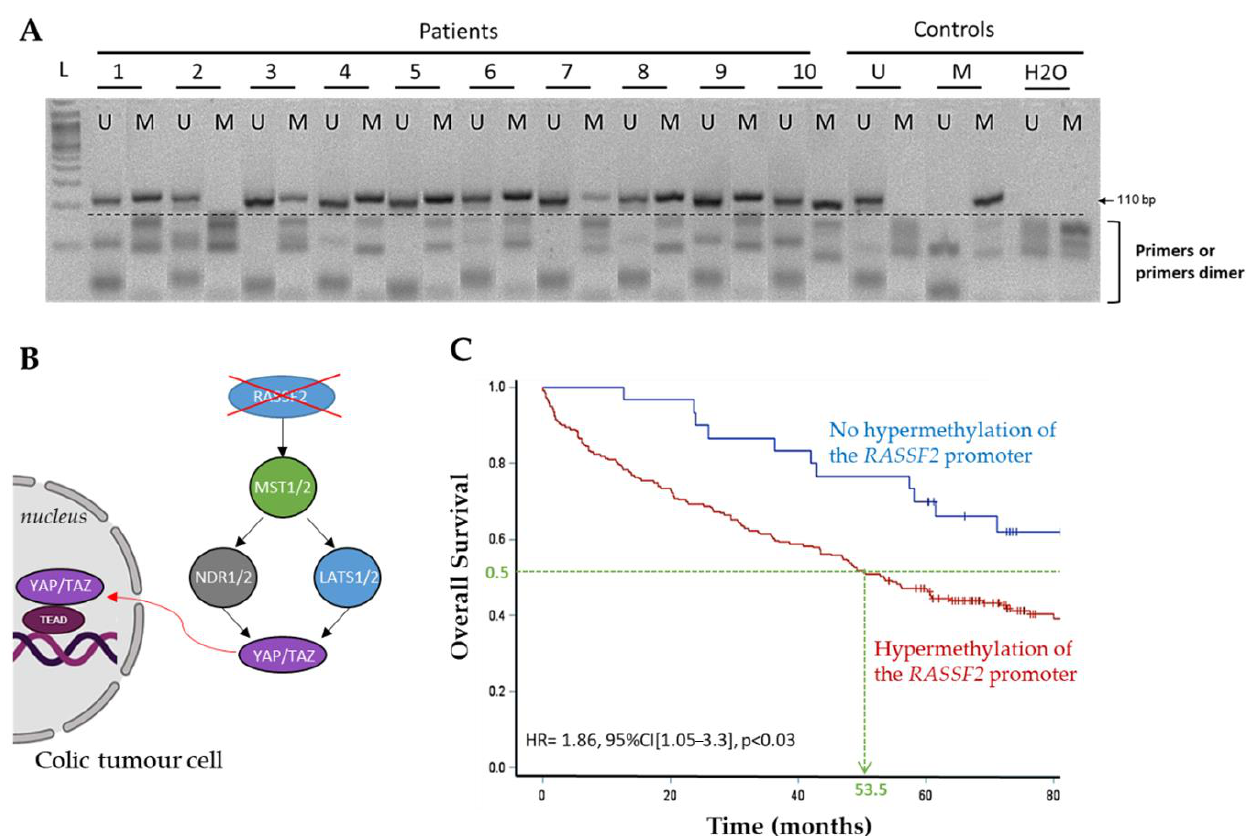
Figure 2. RASSF2 gene promoter hypermethylation predicts worse overall survival in 229 patients with colon cancer. ( A ) Methylation analysis in 10 colon cancer cases. Lane U: amplified product with primers recognizing unmethylated sequence; Lane M: amplified product with primers recognizing methylated sequence. Control “M”: positive control for hypermethylation; Control “U”: positive control for unmethylation (lymphocyte DNA); H 2 O: negative control. The ladder (L) saw at the first lane is 50 bp. ( B ) Diagram of the consequences of the silencing of RASSF2 on the nuclear expression of YAP and TAZ in colonic cancer cells. ( C ) RASSF2 gene promoter hypermethylation impact on overall survival in patients with colon cancer. Table 3. Logistic regression model between histopronostic factors and RASSF2 methylation